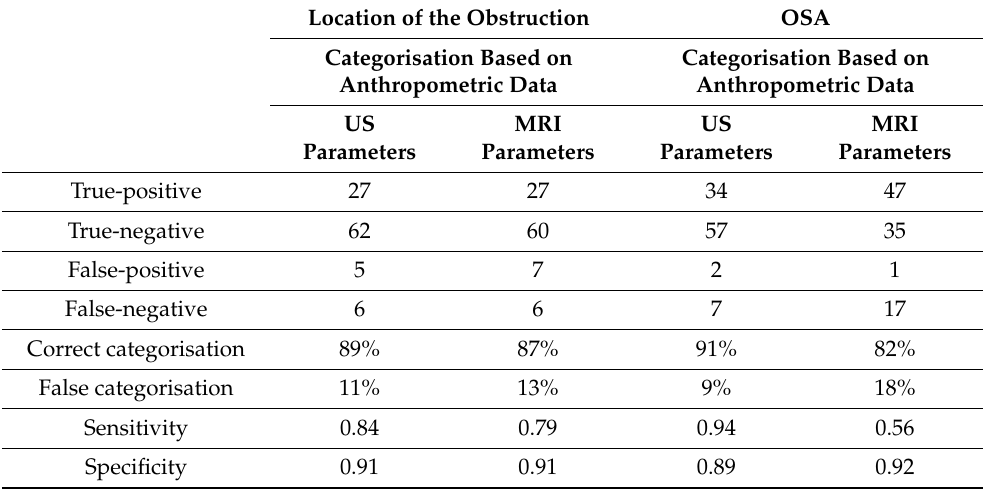
Table 7. Prognosis of tongue-based obstruction and OSA, according to US and MRI measurements (quadratic discriminant